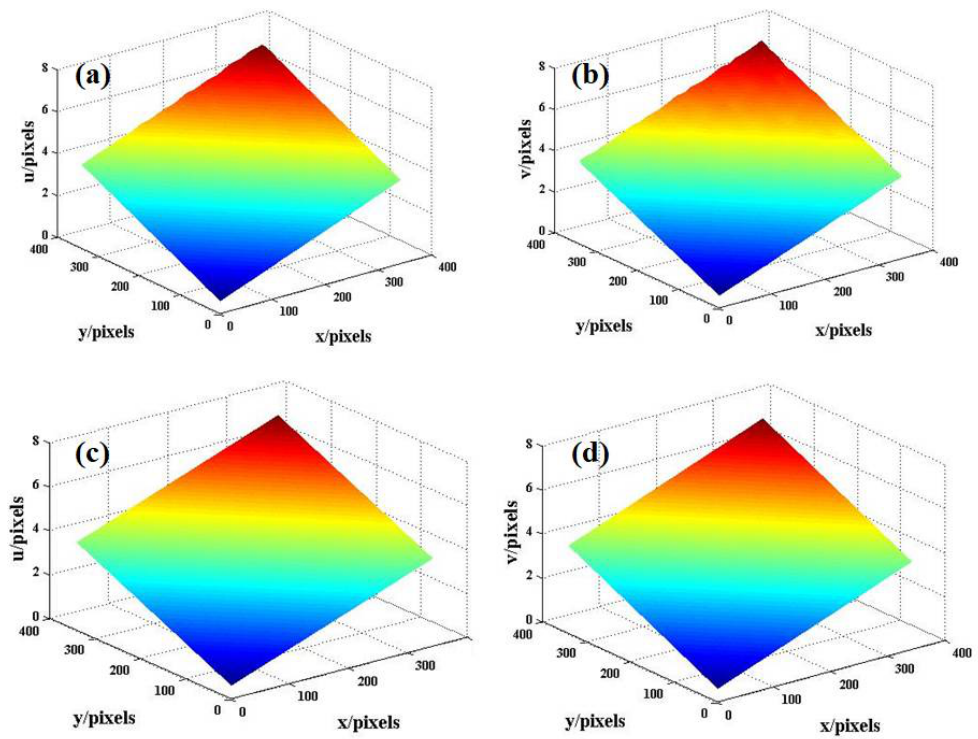
Figure 6. In-plane displacement results of simulation experiment: ( a ) field u (DIC method); ( b ) field v (DIC method); ( c ) field u (OF method); ( d ) field v (OF method).